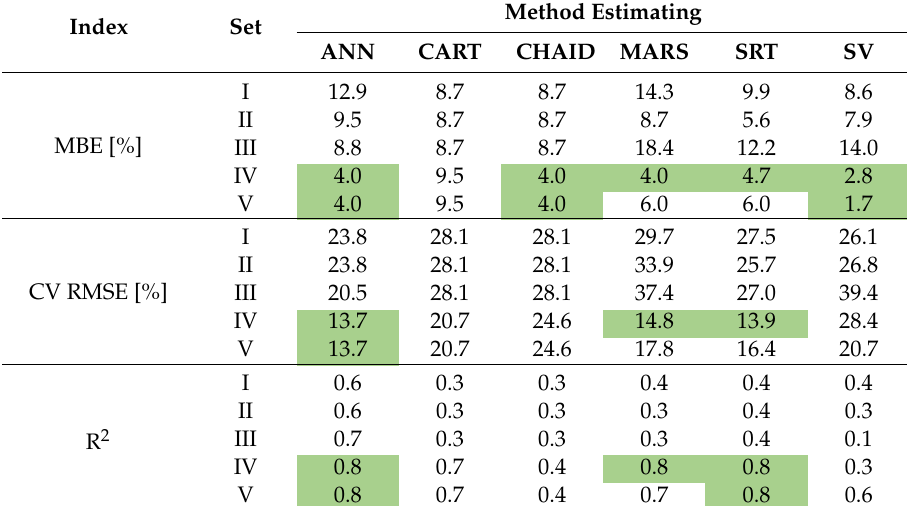
Table 3. Comparison of the Mean Bias Error (MBE), Coe ffi cient of Variation of the Root Mean Square Error) (CV RMSE), coe ffi cient of determination (R 2 ), of selected methods estimating the reduction energy requirement taking into account all accessibles input variables for